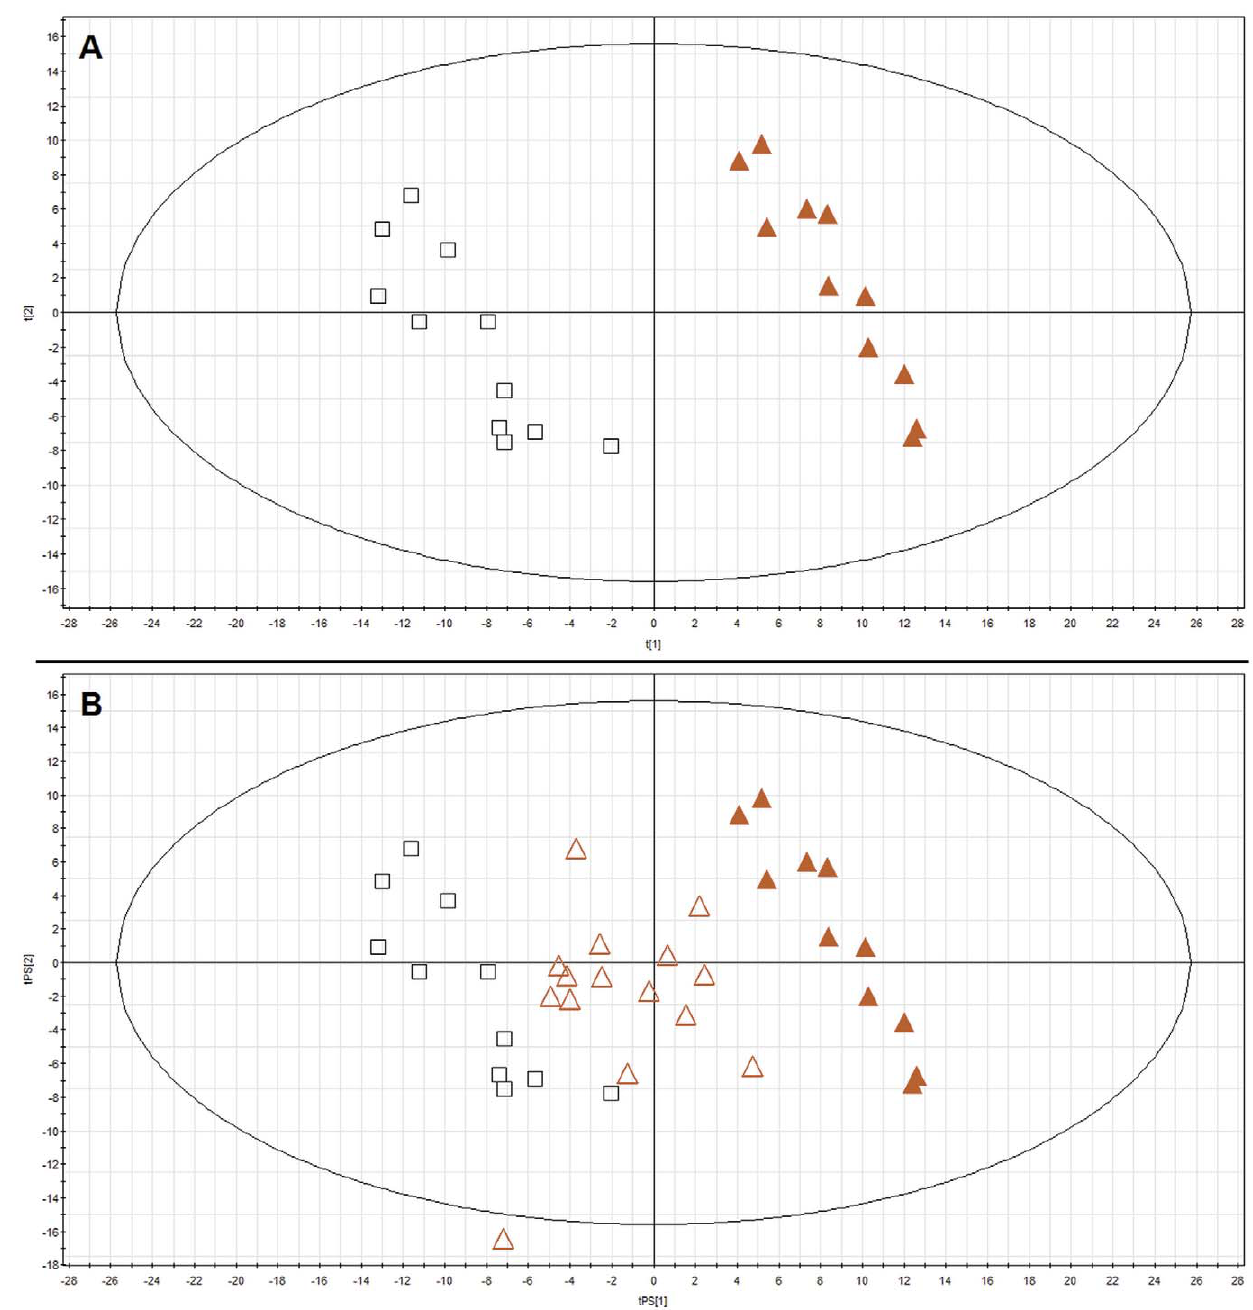
Figure 3. PLS-DA plot of plasma metabolic profiles obtained for age matched large aneurysm patients and controls. n - small AAA, m – large AAA, % – control Panel A shows PLS-DA model (R 2 =0.977, Q 2 =0.817) for plasma samples obtained from patients with large AAA and controls matching in age (n=11). Panel B shows prediction for all samples of small AAA patients.